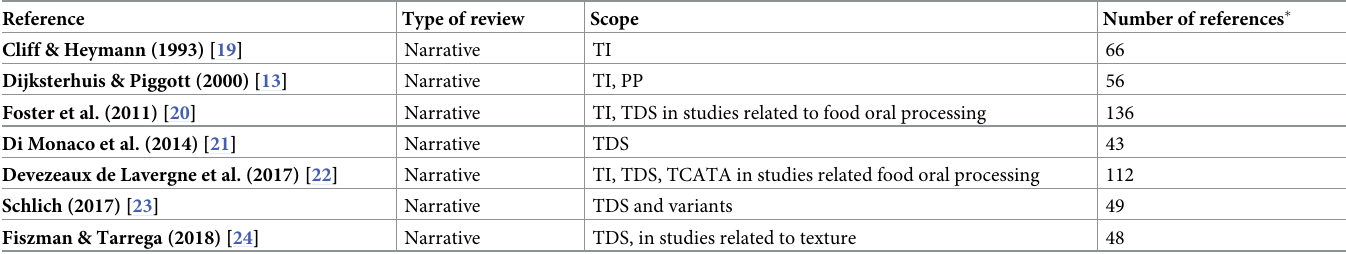
Table 2. Existing reviews related to all temporal methods in sensory science ( � total number of references in each review, as reported in Scopus).